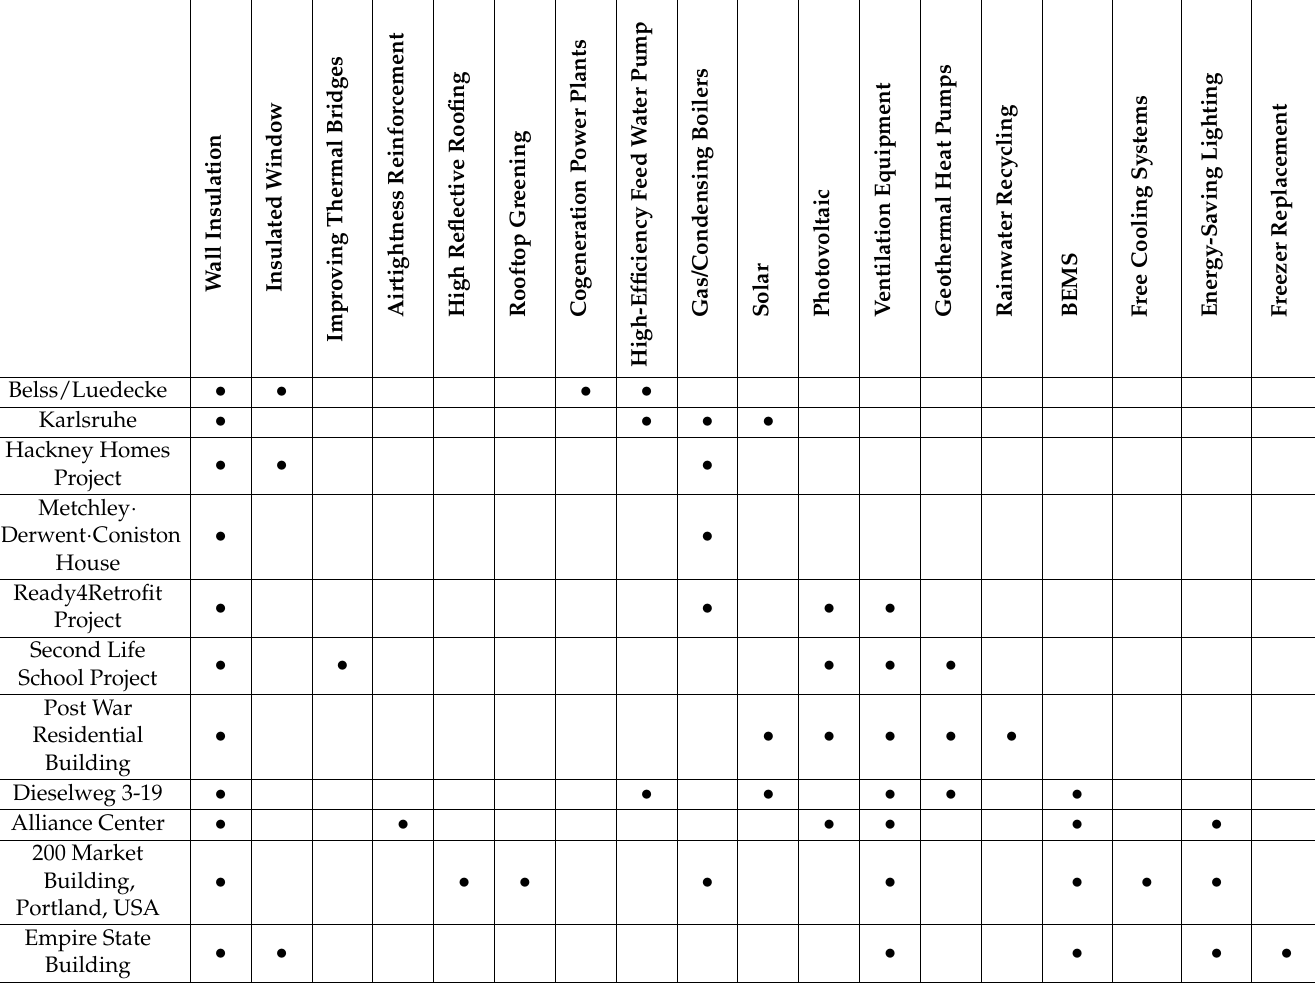
Table 1. Applied technologies for green remodeling in urban regeneration projects in Europe and the United States